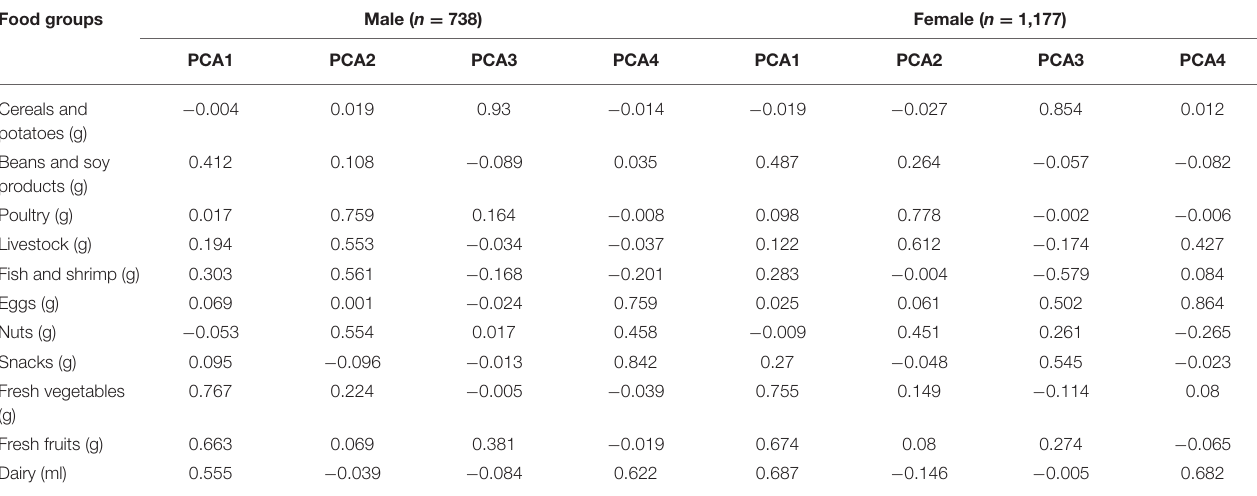
TABLE 4 | Factor load matrix of dietary pattern between men and women. Food groups